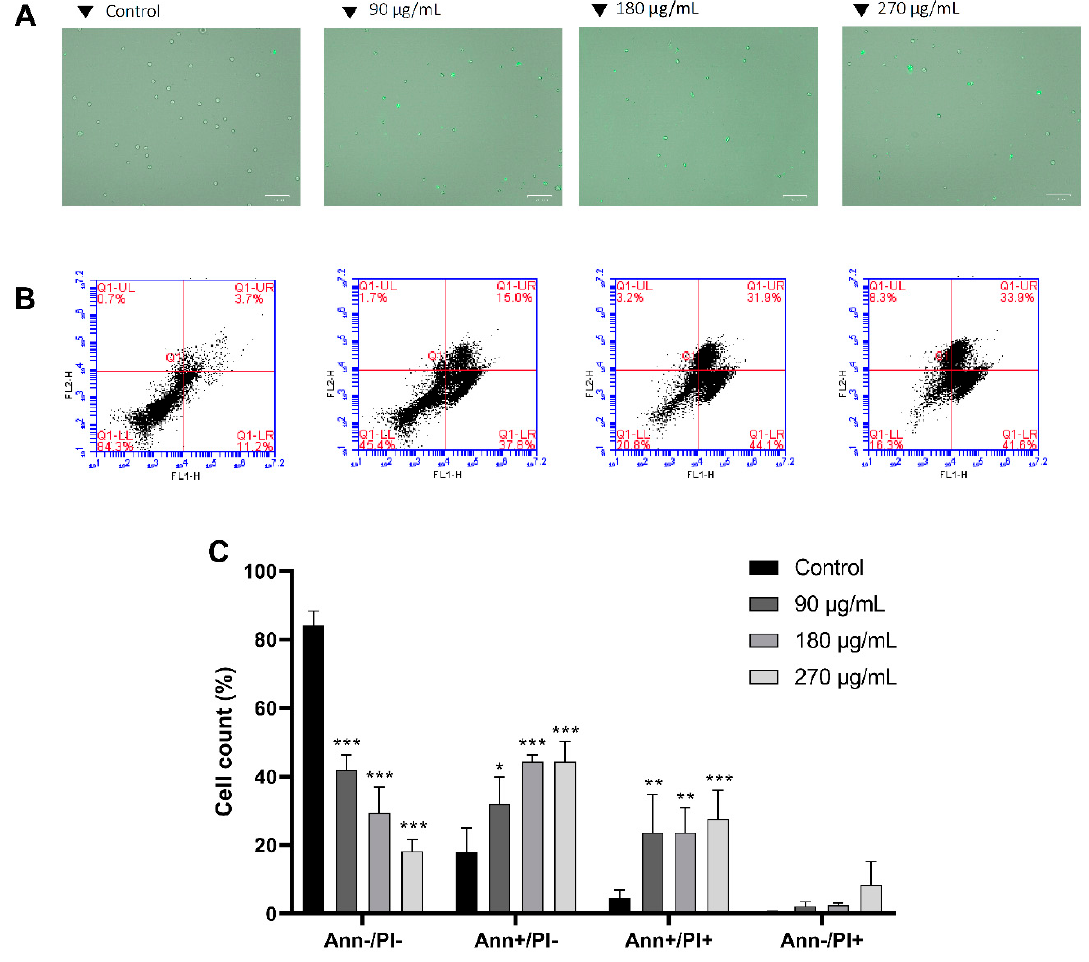
Figure 3. Annexin V ( A ) and annexin V/PI staining ( B and C ) of Monomac-1 cells treated for 24 h with increasing concentrations of MMLE. A significant increase in positively stained cells was observed upon 24 h treatment with increasing concentrations of MMLE (A). A decrease in annexin-negative/PI-negative stained cells and an increase in annexin-positive/PI-negative, annexin-positive/PI-positive, and annexin-negative/PI-positive stained cells were noted in Monomac-1 treated with 90, 180, and 270 µg/mL for 24